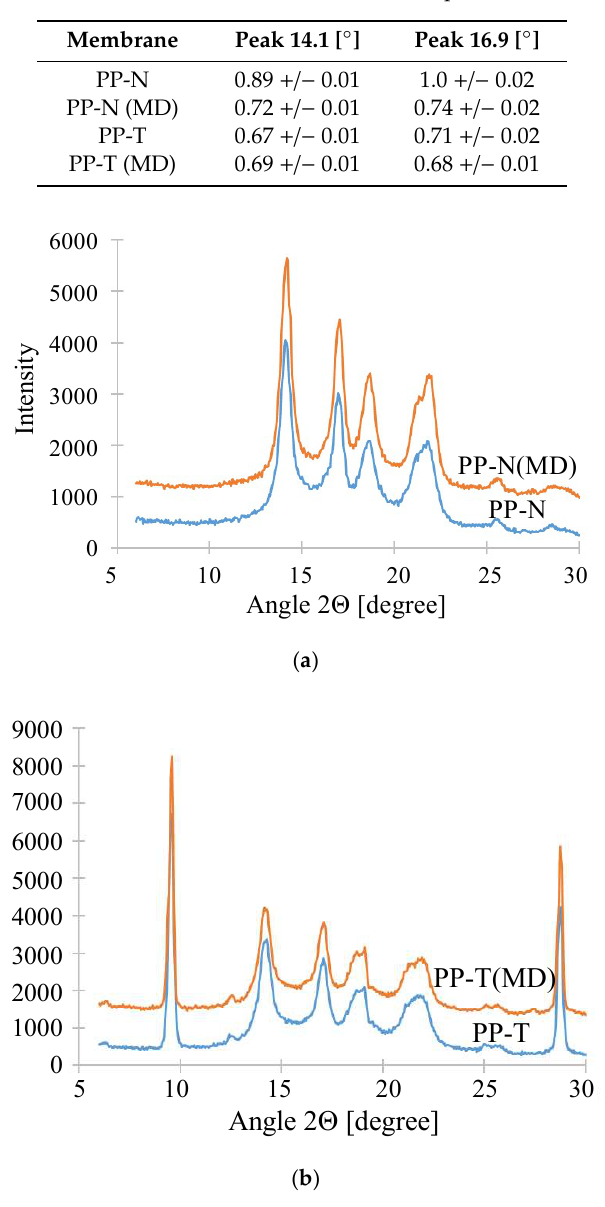
Figure 10. The results of XRD analysis. ( a ) membrane PP-N, ( b ) membrane PP-T.